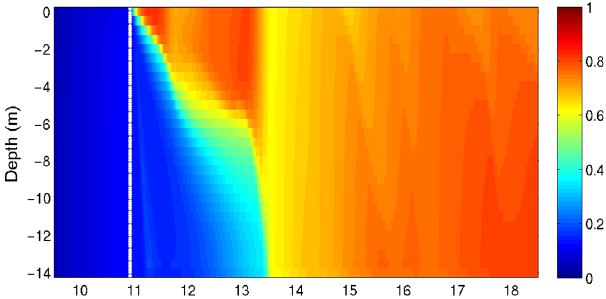
Fig. 10. Modelled PFe concentration (µmolm − 3 ) in DUST-meso. The white bar shows the time of dust addition.